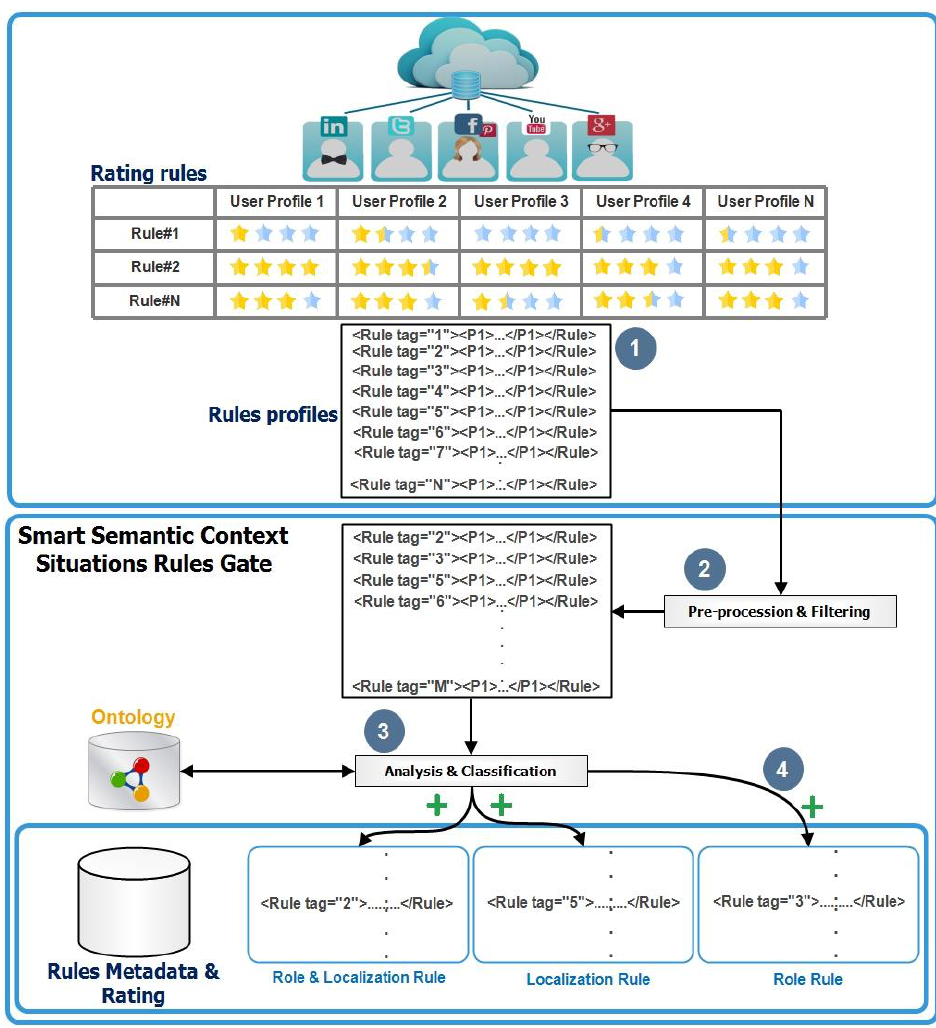
Figure 3. An overview of situation rules learning process.